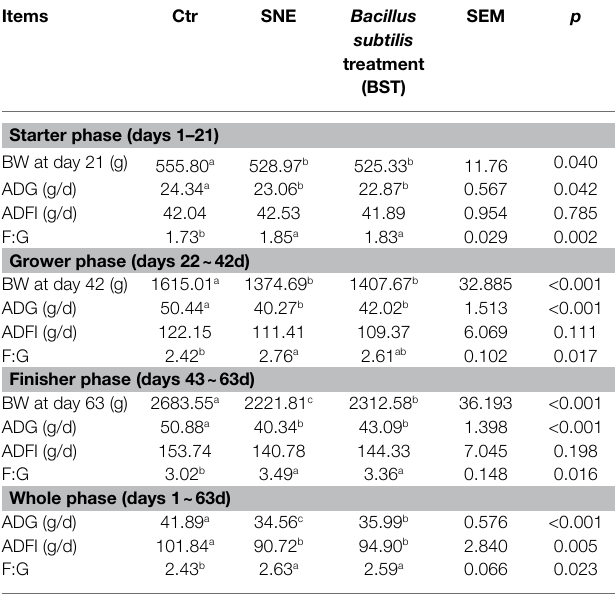
TABLE 3 | Effects of Bacillus subtilis DSM29784 treatment group on the growth performance of subclinical enteritis (SNE)